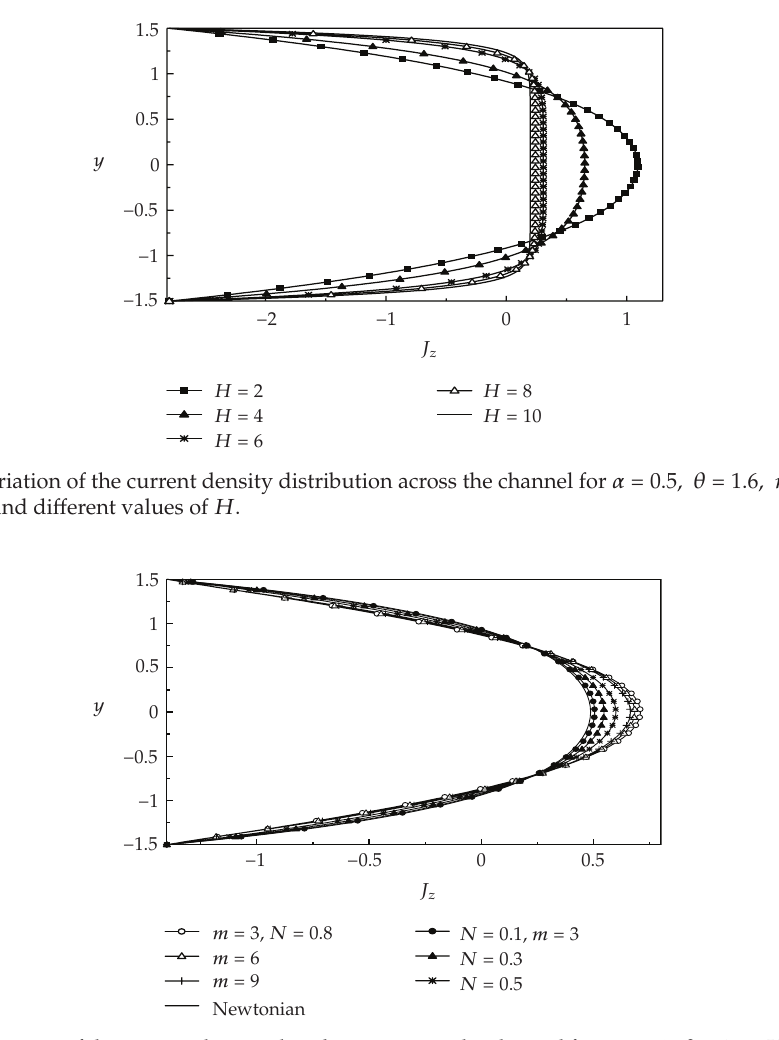
Figure 12: Variation of the current density distribution across the channel for α (cid:8) 0 . 5 , θ (cid:8) 1 . 6 , H (cid:8) 2 , R m (cid:8) 1, and di ff erent values of m and N